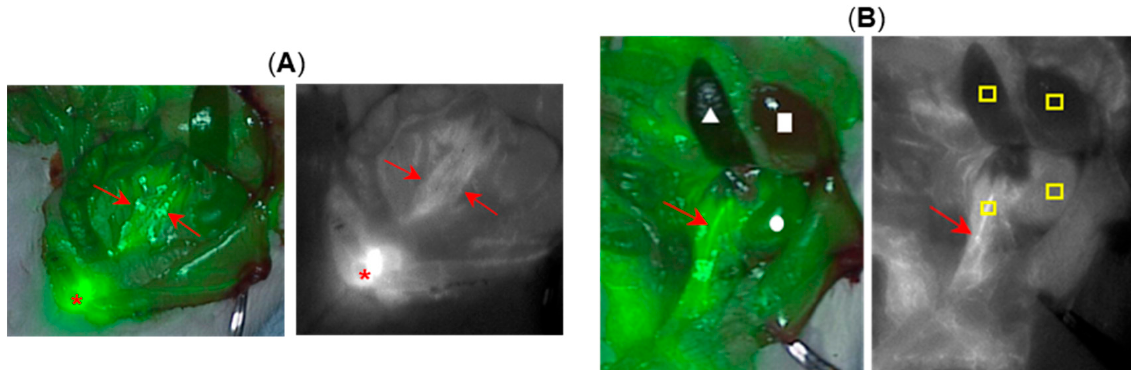
Figure 6. Representative imagery from surgical rat model study showing exposed ureters ( n = 3). (A) Image recorded at 35 min post-administration of 12 . Left, fluorescence (pseudo coloured green) overlaid on white light image. Right, fluorescence alone shown as black and white for clarity. Both ureters indicated by red arrows and bladder by asterisk. (B) Image recorded at 50 min. Left, fluorescence (pseudo coloured green) overlaid on white light image, red arrow (ureter), circle (kidney), triangle (spleen), square (liver). Right, fluorescence alone shown as black and white for clarity. Red arrow identifying ureter and yellow boxes indicate regions from which the average pixel intensity data were obtained.